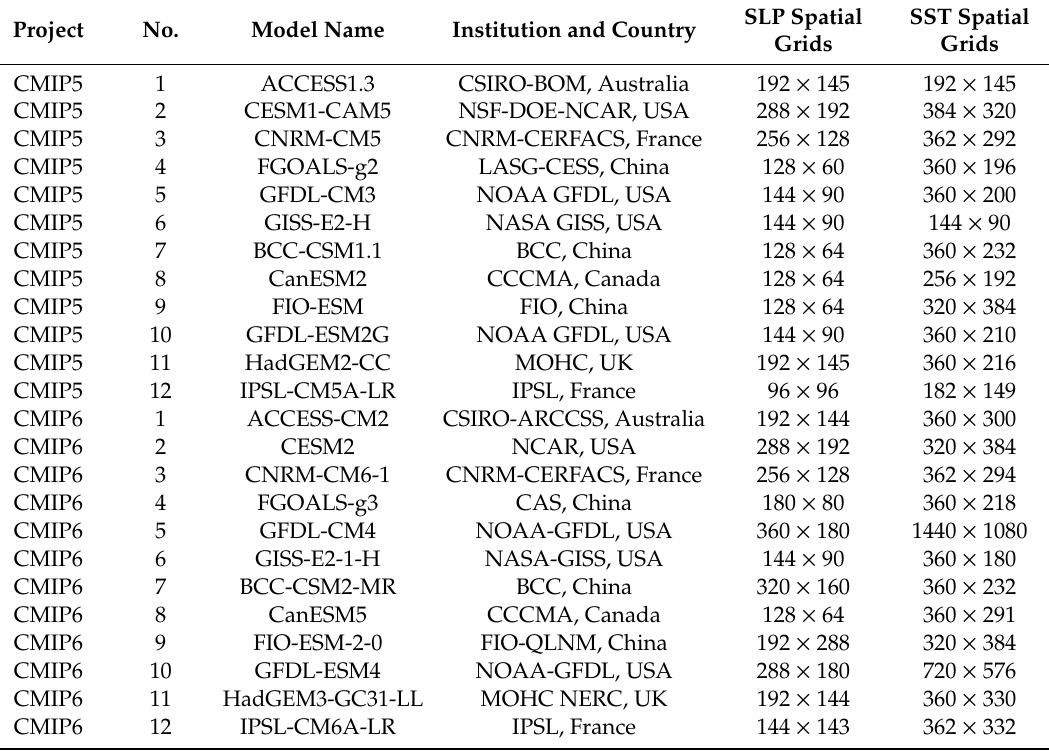
Table 1. Basic information for the 24 selected CMIP5 and CMIP6